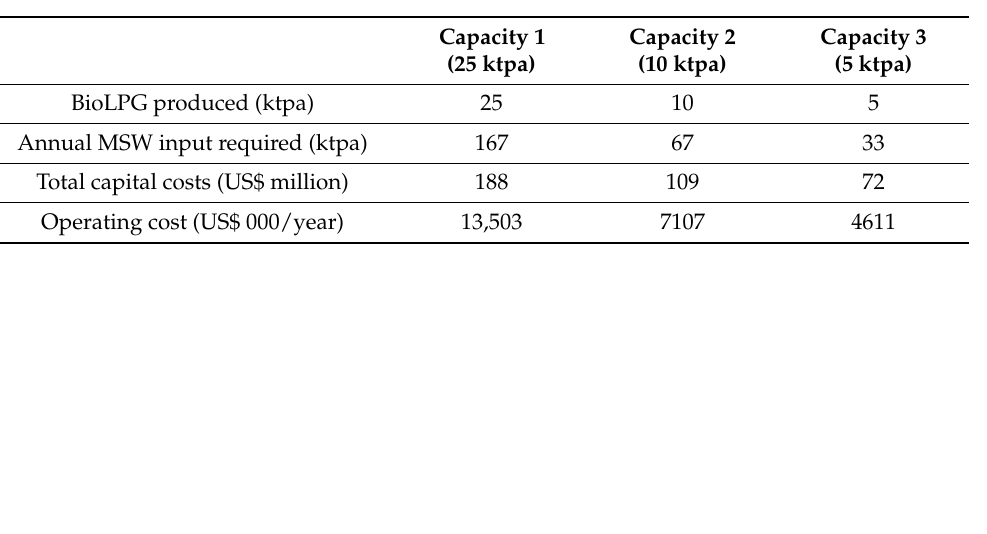
Table 4. Capital and operating costs of an IH 2 plant in Ghana or Rwanda before feedstock